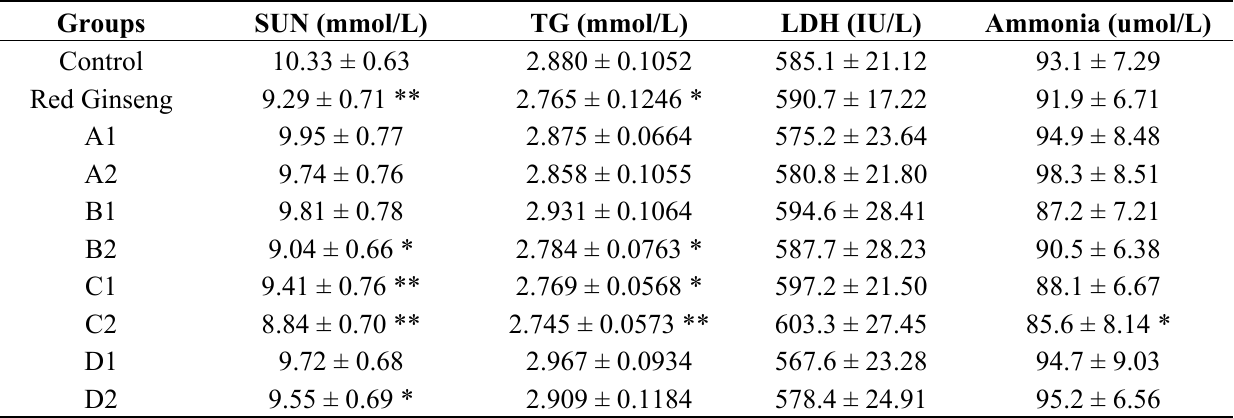
Table 3. The effects of the fractions of RPL and red ginseng on SUN, TG, LDH and